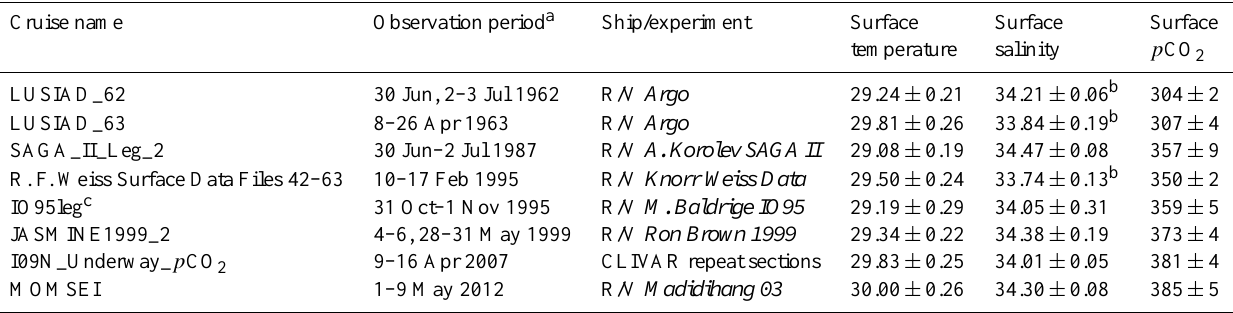
Table 1. Summary of cruise information and mean values of surface temperature, salinity, and surface p CO 2 in the equatorial belt (2 ◦ N–2 ◦ S, 90–95 ◦ E), which are reported as mean ± standard deviation. These mean values in this table are calculated as described in Sect. 2.2.2, and are not deseasonalized.